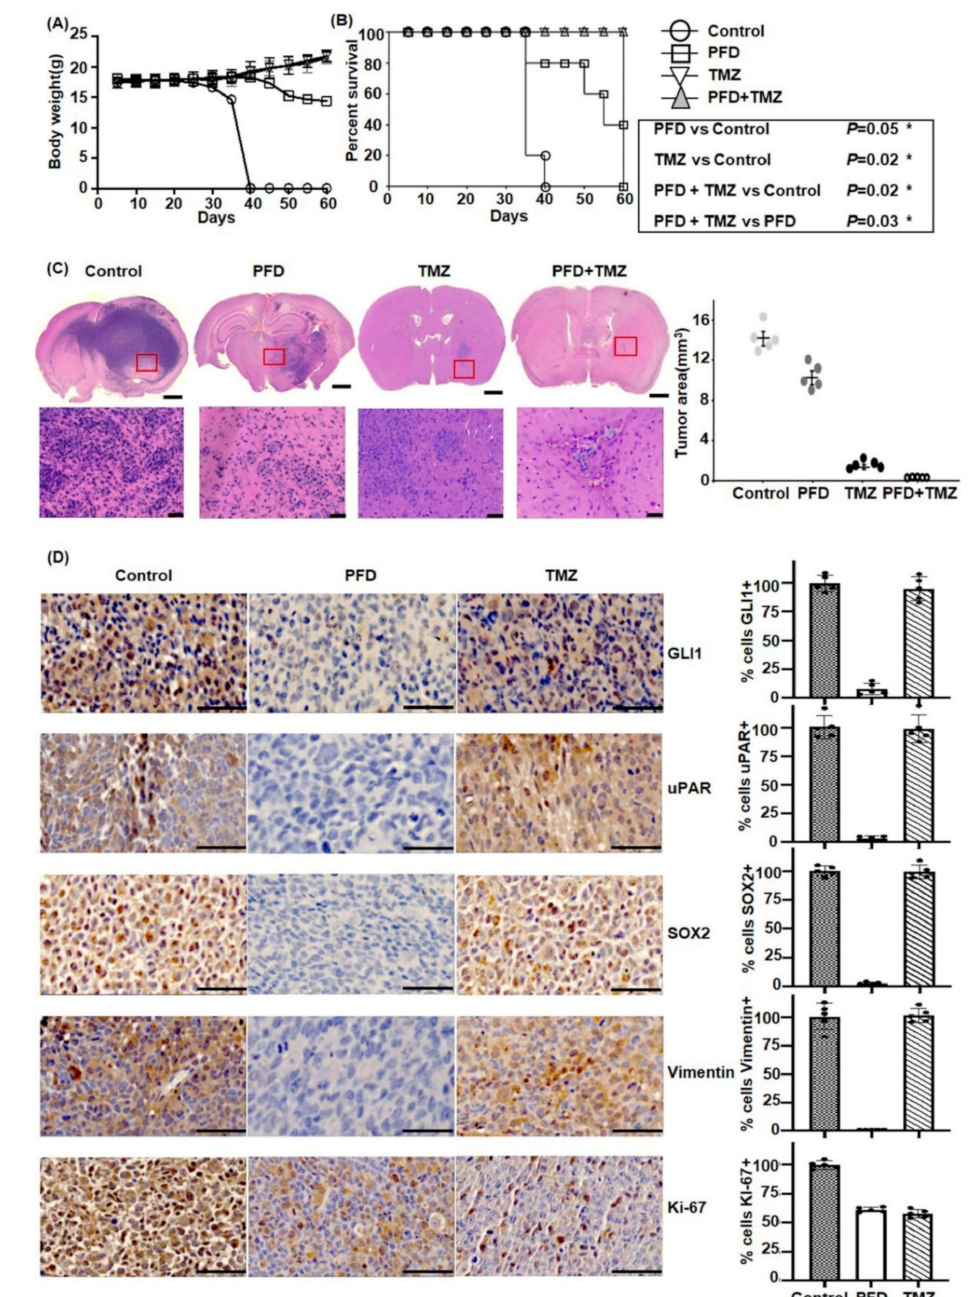
Figure 5. PFD exhibits antitumor e ff ect and increases survival in vivo. ( A ) The body weight of mice after administration of di ff erent formulations of PFD and TMZ up to day 60 ( n = 5). ( B ) Kaplan-Meier survival curve of mouse implanted with 1 × 10 4 CSC2 GSCs. Mice were treated with PBS control, 0.8 mg / week PFD, 33 mg / kg TMZ, and PFD + TMZ combination ( n = 5, log-rank test results are shown in the inset). ( C ) Histopathology of mouse brains obtained after 40 days post-implantation. The tissues were stained with H&E to detect tumor size (Scale bar: 1000 µ m) and invasiveness (Scale bar: 50 µ m). Tumor volume in mice was measured by Image Tool 3.00 (*** p ≤ 0.001, One-way ANOVA, Student-Newman–Keuls post hoc test). ( D ) Tumor tissues were sectioned and immunostained for detecting the expression of GLI1, SOX2, uPAR, Vimentin and Ki-67. Representative images are shown and data are presented as mean ± SD (Scale bar: 50 µ